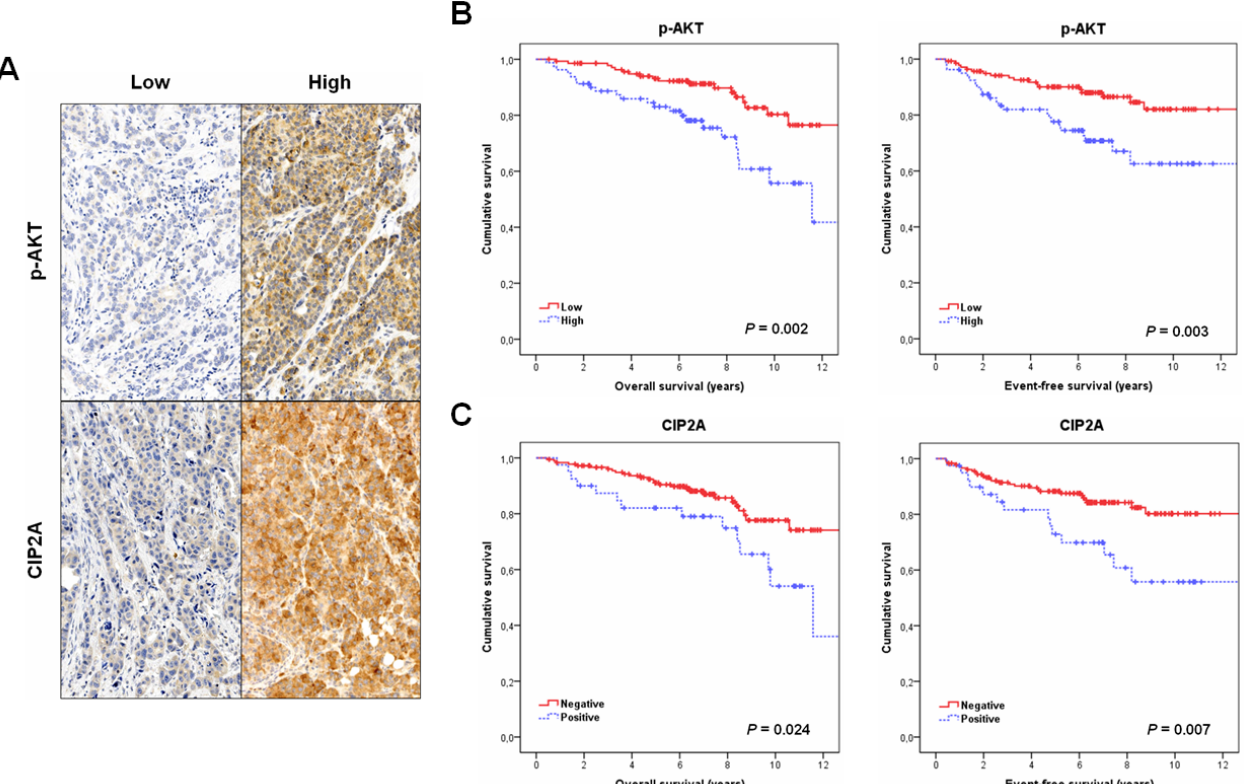
Figure 1. Clinical significance of p-AKT and CIP2A in early breast cancer. ( A ) Immunohistochemical detection of p-AKT and CIP2A showing positive and negative staining. Magnification × 400. Kaplan–Meier analyses of OS and EFS for p-AKT ( B ) and CIP2A ( C ) in a cohort of 220 early breast cancer patients.